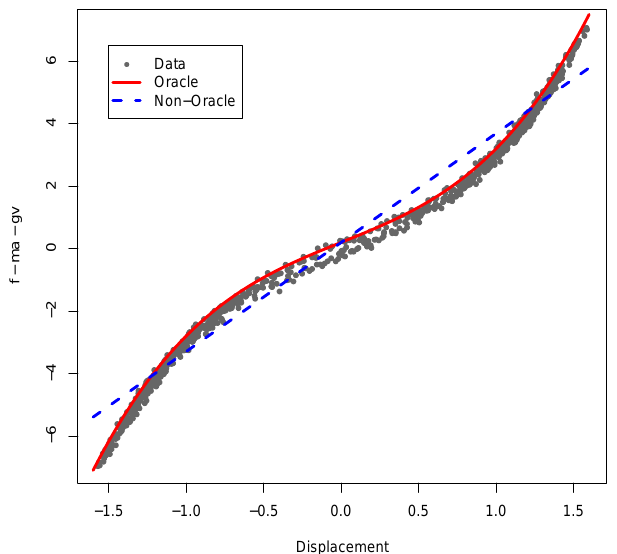
Figure 2. Force versus Displacement with Oracle and Non-Oracle models using forcing given by (9) with A c = 5 and centered Gaussian internal error with σ ϵ = 0.1.